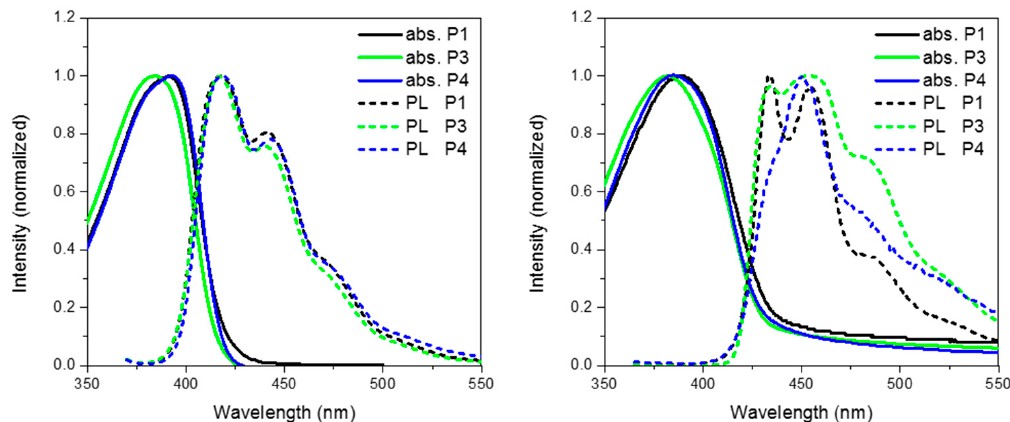
Figure 6. Thin film absorption, emission and HOMO and LUMO of P3 and P4 .